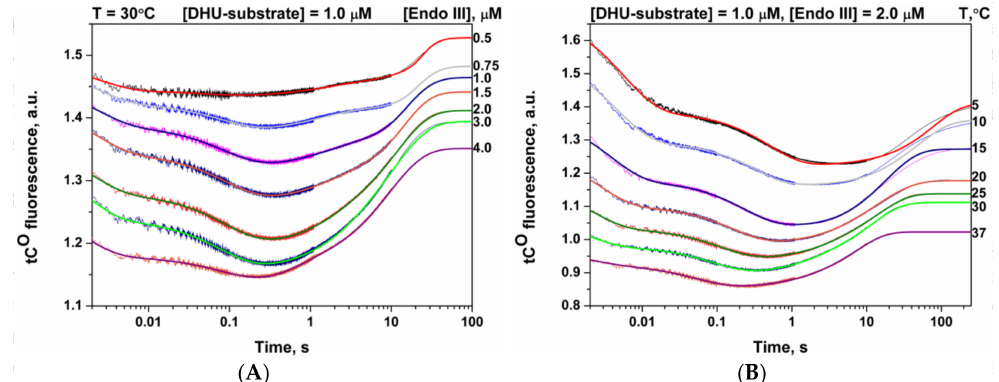
Figure 4. ( A ) Changes in tC O fluorescence intensity during the interaction of Endo III with DHU-substrate (1 µ M) at various concentrations of the enzyme at 30 ◦ C. Solid lines represent the curves fitted by means of Scheme 3; ( B ) Changes in tC O fluorescence intensity during the interaction of Endo III (2 µ M) with DHU-substrate (1 µ M) at different temperatures.